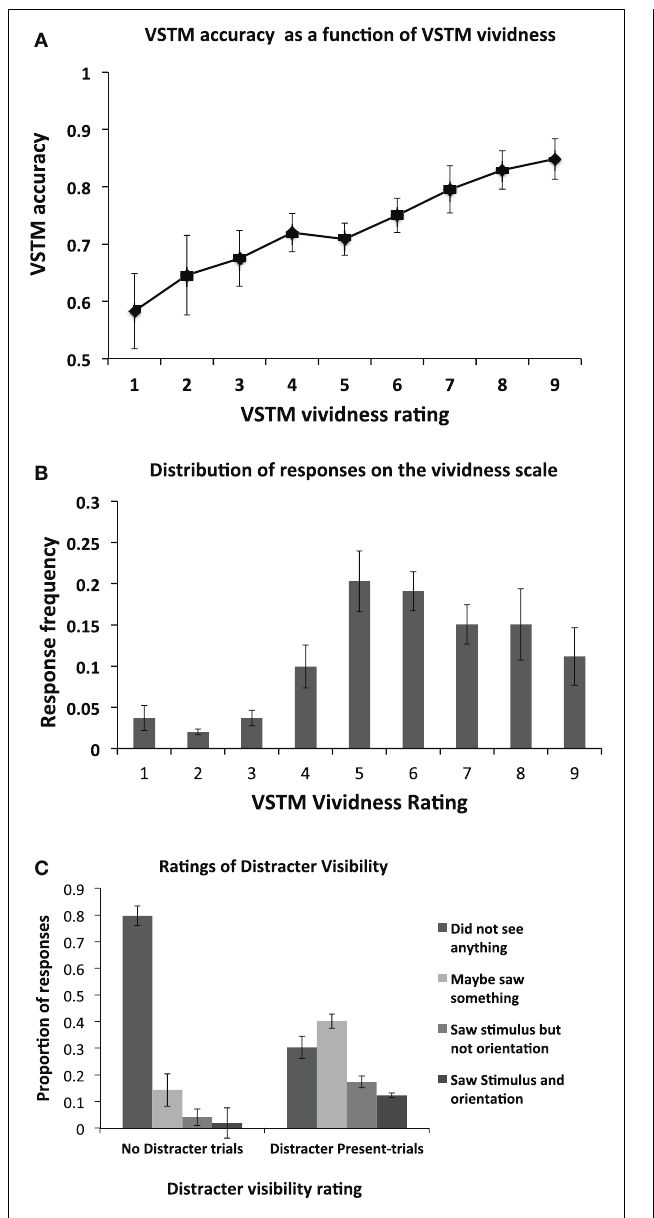
FIGURE 2 | (A) Mean ( n = 14) objectiveVSTM accuracy as a function of subjectiveVSTM vividness. On each trial, in addition to performing the objectiveVSTM discrimination task, participants were asked to provide a rating of the subjective vividness of their memory representation using a 1–9 scale. As expected, there was a positive correlation between these measures, with highVSTM accuracy associated with high levels of subjective vividness.This correlation was statistically significant (Pearson’s r = 0.459; p < 0.01). Error bars indicate ± 1 SEM. (B) The distribution of participants’ responses on the vividness scale. On each trial, participants were asked to indicate the subjective vividness of their memory representation on a scale ranging from 1 to 9.The figure indicates the proportion of responses for a given category of vividness. (C) Proportion of visibility responses for the masked visual distracter presented during the maintenance period for the No Distracter- and Distracter-Present conditions.